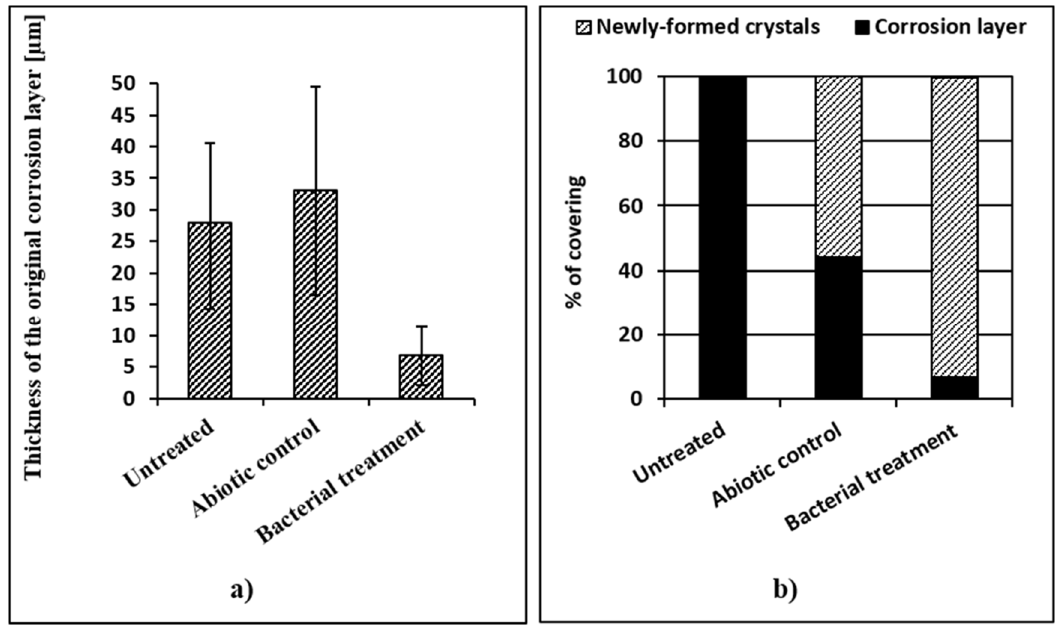
Figure 3. Efficiency of the treatment in terms of thickness and surface covering: ( a ) a graphic representation of the thickness of the corrosion layer of untreated, abiotic control, and bacterially treated iron coupons; ( b ) an estimation of the surface covered by iron phosphates by microscopic observation of the cross-sections.